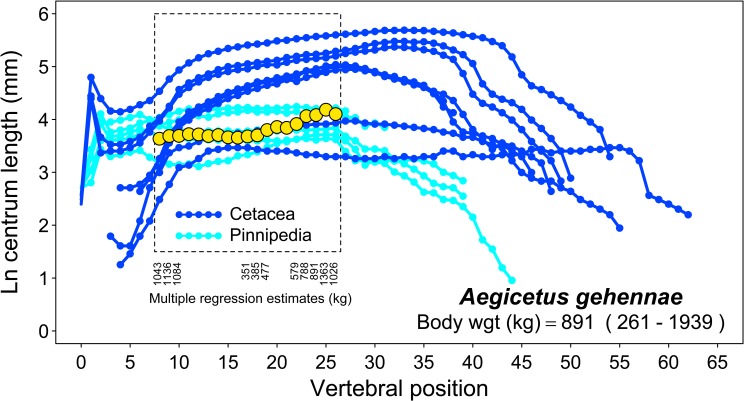
Body weight estimate for Aegicetus gehennae.The preferred estimate of 891 kg (rounded to 890 kg) is the median of 11 independent multiple regressions of body weight on centrum length, width, and height for vertebrae 8 through 26 (T1 through L4; Table 2). Colored lines are traces of vertebral centrum length for eight extant cetacean and five extant pinniped taxa forming the reference set (corresponding centrum widths and heights are not shown). Yellow circles show centrum lengths for A. gehennae. Dashed rectangle encloses core vertebrae of interest for body weight prediction. Note that the ordinate is on a proportional scale (original measurements are in mm). See [43] for further explanation and documentation.